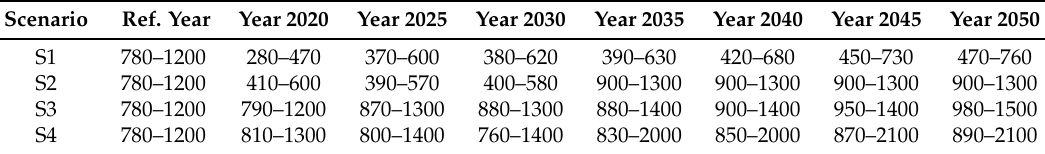
Table 3. Average total annual electricity demand for LADWP’s water supply for the historical reference and projection years between 2020 and 2050 for S1-S4 scenarios. All values are in GWh and are rounded to two significant digits.